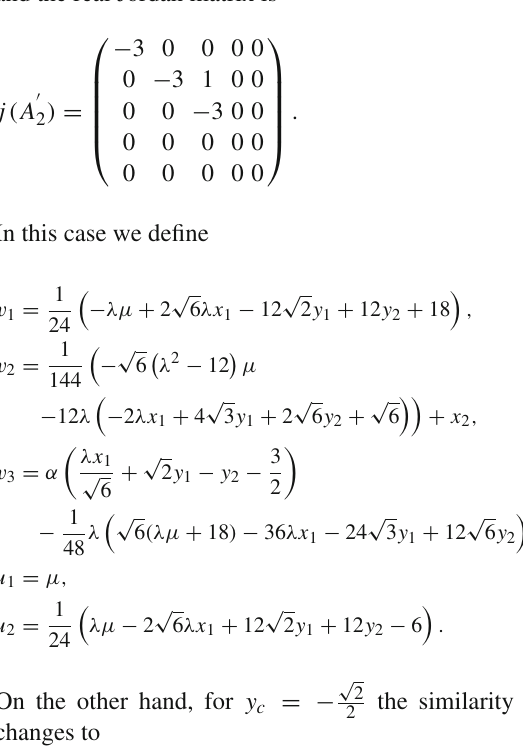
is a saddle point 2